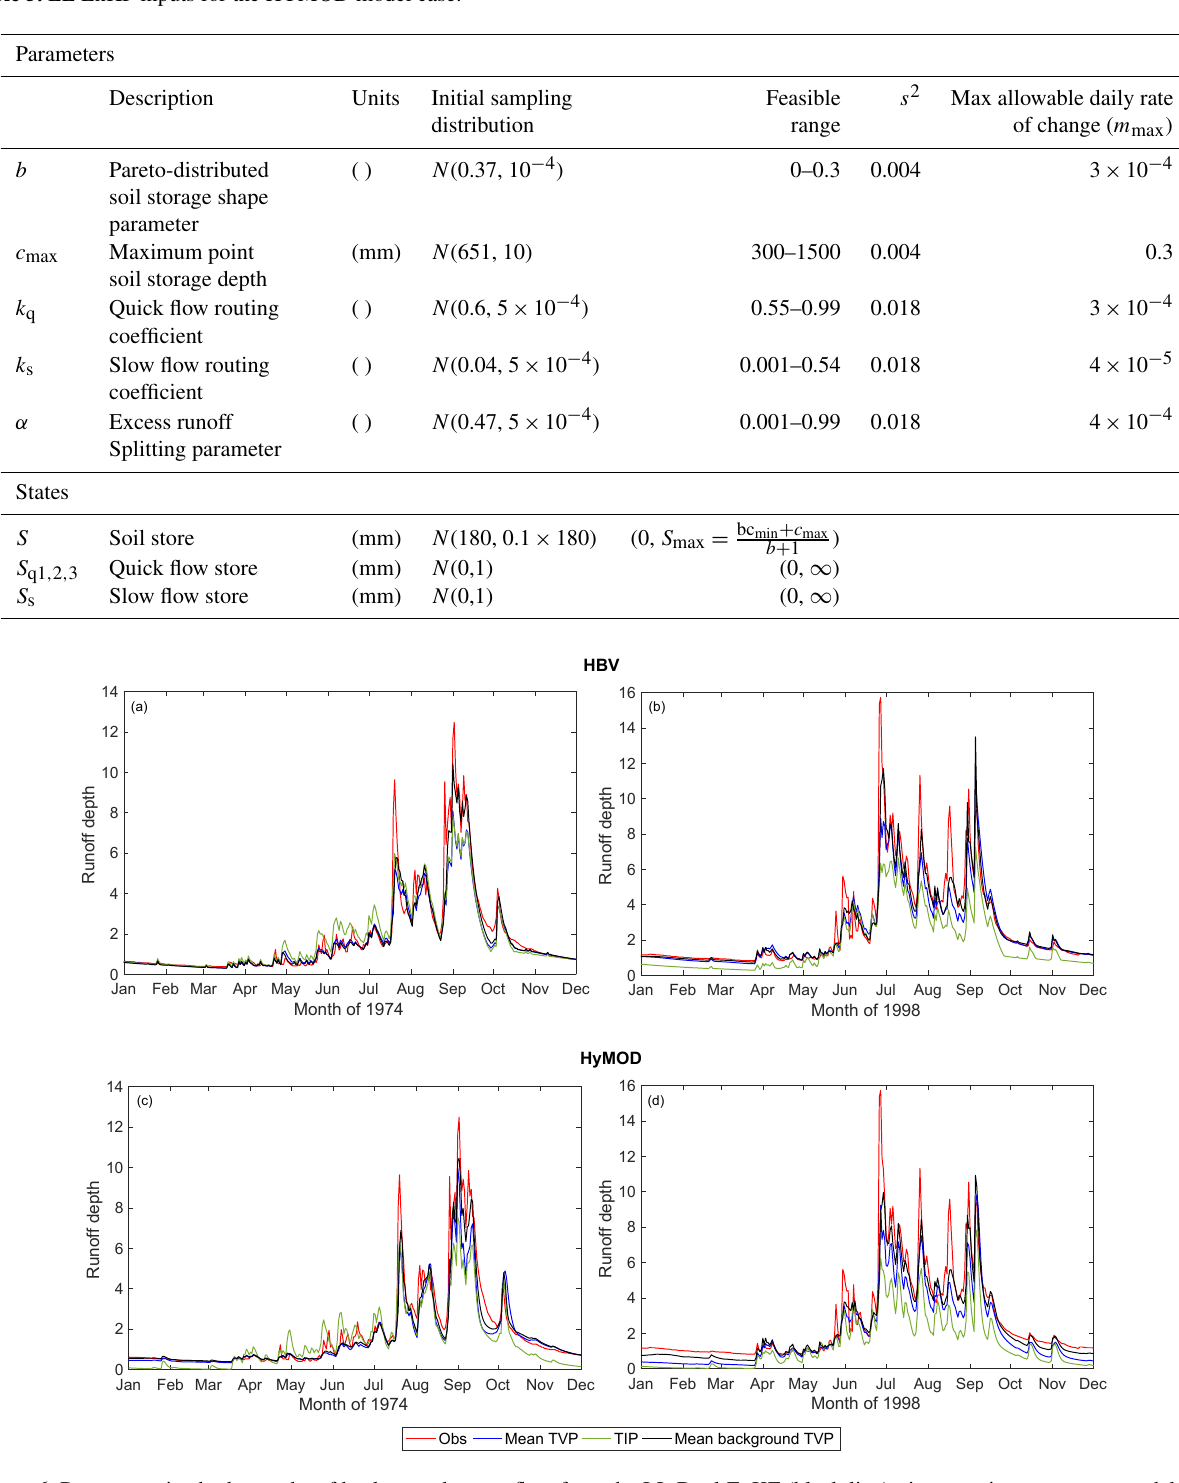
Figure 6. Representative hydrographs of background streamflow from the LL Dual EnKF (black line), time-varying parameter model with no state updating (blue line), time-invariant parameter model with no DA (green line) and observed streamflow (red line). Results for HBV are shown in the top row and HyMOD in the bottom row. A pre-change year (1974) is shown on the left and a post-change year (1998) on the